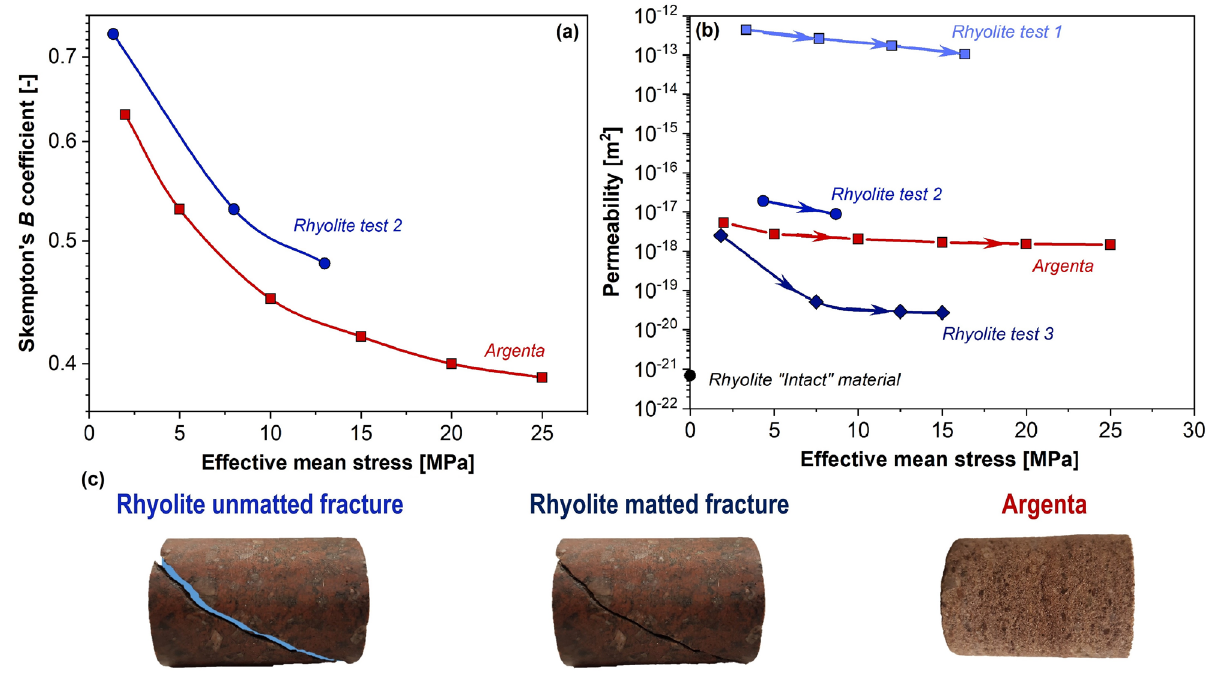
Figure 4. ( a ) Skempton’s B coefficient and ( b ) permeability of fractured Precambrian rhyolite and Argenta sandstone as functions of effective mean stress. The permeability of fractured rhyolite is highly sensitive to specimen assembling and fracture opening. ( c ) Photographs of tested specimens. Tests are performed on cylindrical specimens with a diameter of 20 mm and a height of 30